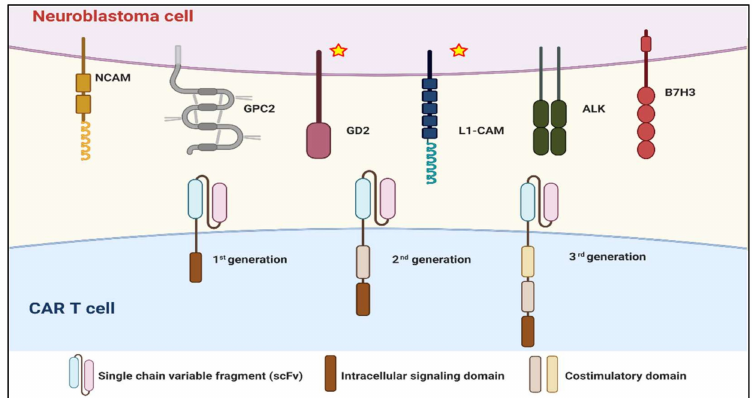
Figure 2. Target antigens conducted on the safety and e ffi cacy of CAR therapy for neuroblastoma. Six surface antigens of neuroblastoma, including L1-CAM, GPC2, NCAM, GD2, ALK, and B7H3, are under development and investigation. L1-CAM and GD2 are the only two target antigens currently in completed clinical trials for neuroblastoma (labeled with